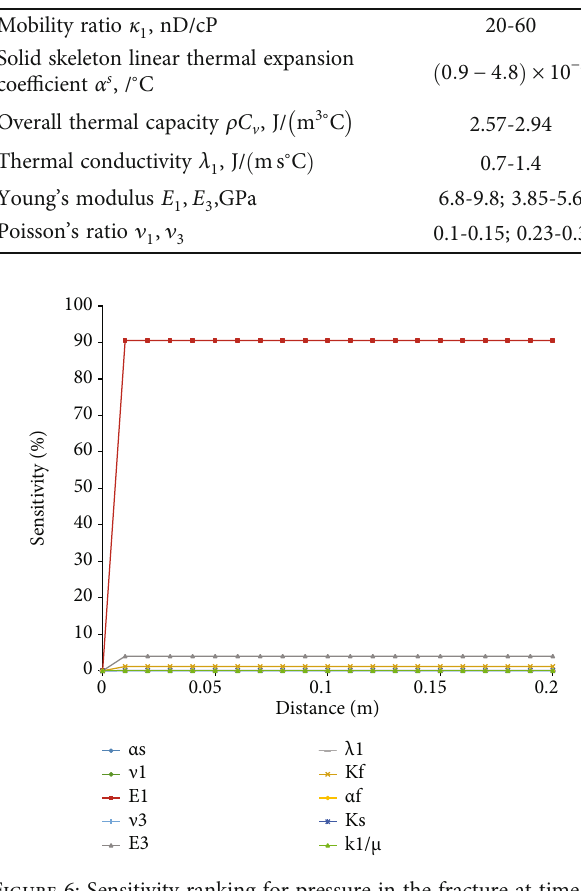
Figure 6: Sensitivity ranking for pressure in the fracture at time t = 0 + . The instantaneous pore pressure jump is 90% governed by Young ’ s modulus E 1